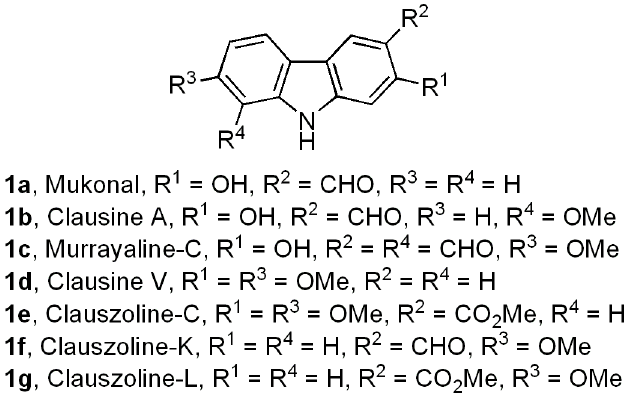
Figure 1. Examples of naturally occurring 2-, 7-, and 2,7-oxygenated tricyclic